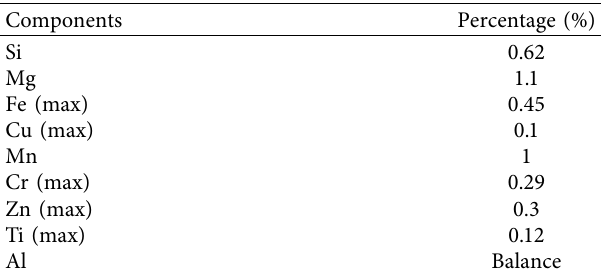
Table 1: Chemical composition of aluminum alloy 6082-T6.